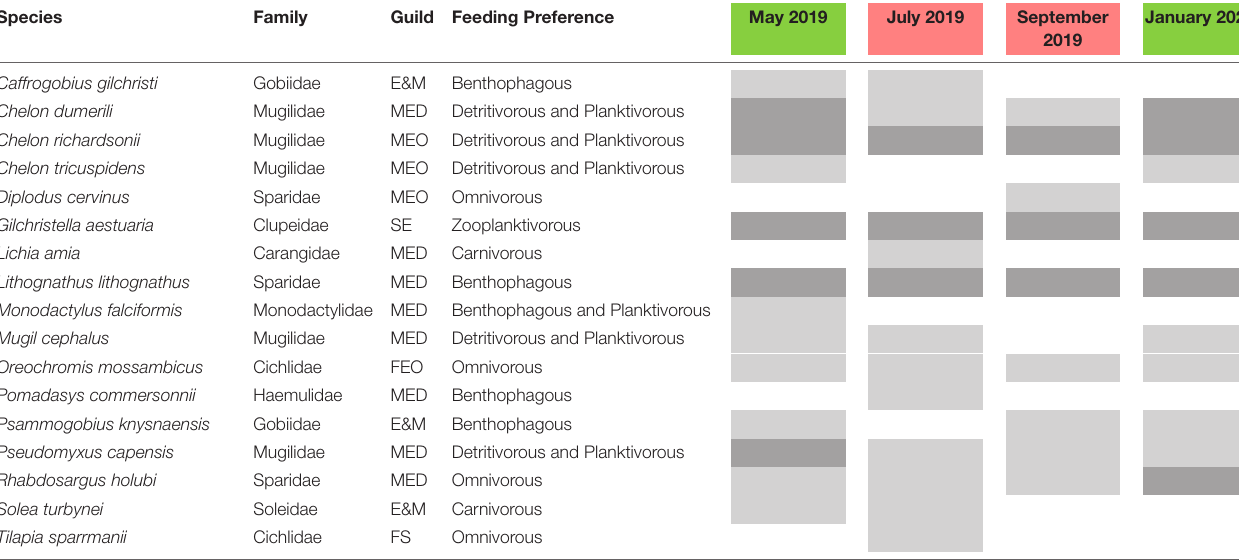
TABLE 2 | List of fish species recorded during each sampling interval and mouth condition (red, closed; green, semi-closed) categorised according to functional guilds, general feeding preferences, and relative abundance (*light grey: > 0 but < 10% RA; dark grey: ≥ 10% RA). Species Family